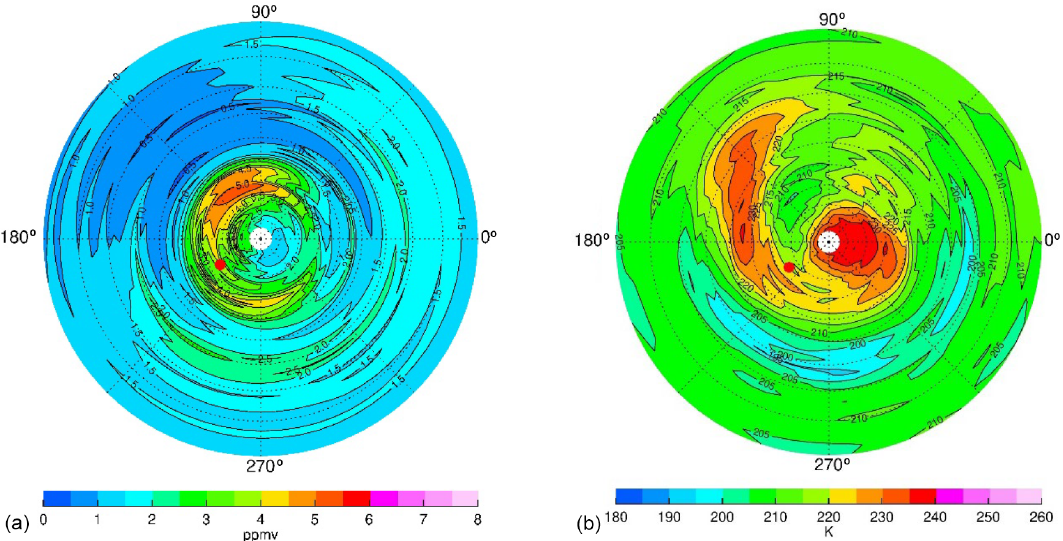
Figure 13. NH distributions for 15 December at 0.022hPa for (a) ozone and for (b) temperature; CIs are 0.5ppmv and 5K, respectively. Red dot denotes location of Poker